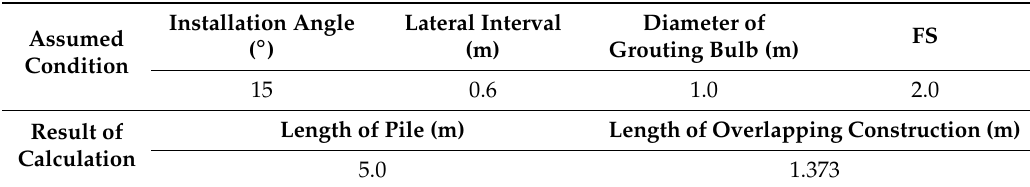
Table 5. Pile properties.